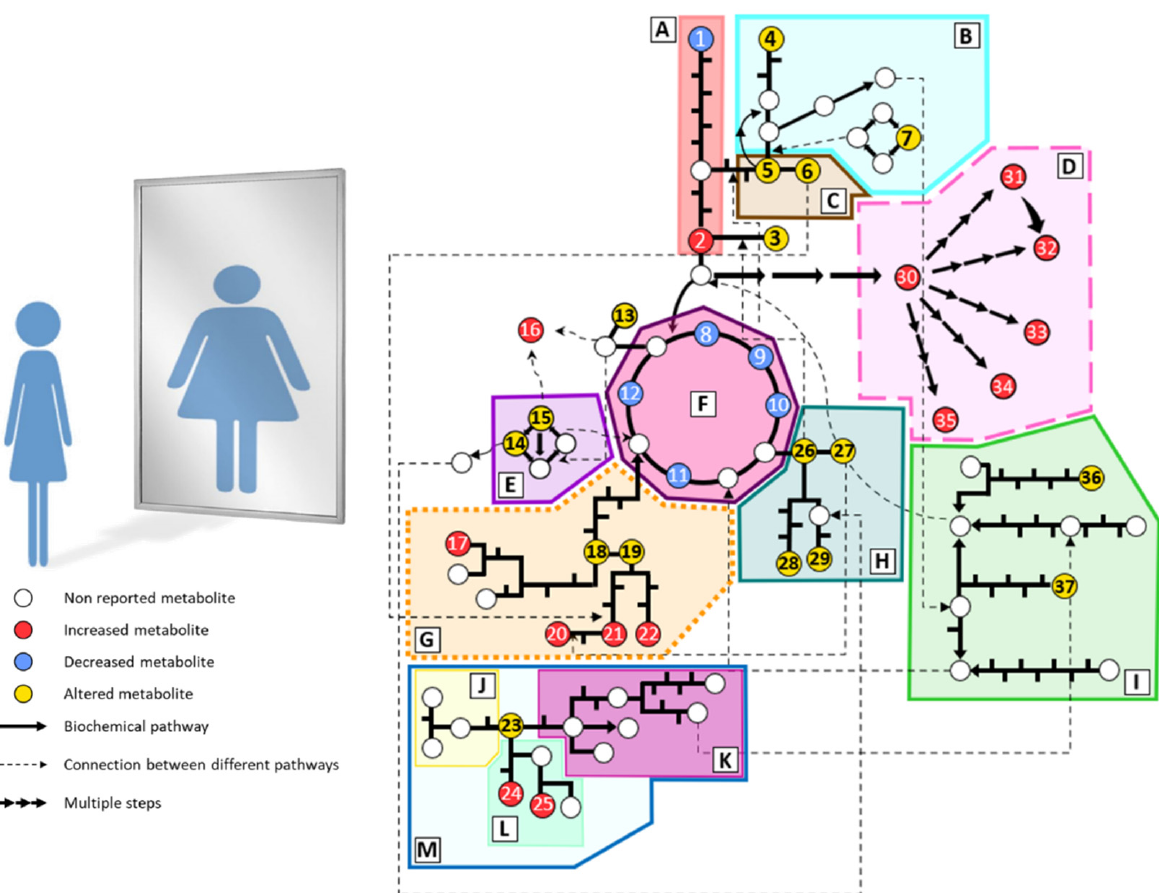
Figure 2. Summary of the main metabolomic alterations found in plasma or serum samples from AN patients in the included studies. Altered pathways: ( A ) glycolysis and gluconeogenesis, ( B ) methionine and cysteine metabolism, ( C ) serine and glycine metabolism, ( D ) lipid metabolism, ( E ) urea cycle, ( F ) tricarboxylate cycle, ( G ) phenylalanine and tyrosine metabolism, ( H ) glutamate, glutamine, proline and histidine metabolism, ( I ) branched-chain amino acids metabolism, ( J ) serotonin pathway, ( K ) kynurenine pathway, ( L ) indole pathway, ( M ) tryptophan metabolism. Metabolites: (1) glucose, (2) pyruvate, (3) alanine, (4) taurine, (5) serine, (6) glycine, (7) methionine, (8) citrate, (9) cis-aconitate, (10) isocitrate, (11) succinate, (12) malate, (13) asparagine, (14) ornithine, (15) arginine, (16) guanidinosuccinate, (17) p -cresyl sulfate, (18) tyrosine, (19) phenylalanine, (20) phenylacetylglutamine, (21) phenylacetate, (22) hippurate, (23) tryptophan, (24) indole-3-acetate, (25) indoxyl sulfate, (26) glutamate, (27) glutamine, (28) histidine, (29) proline, (30) fatty acids, (31) phosphatidylcholines, (32) lysophosphatidylcholines, (33) sphingomyelins, (34) acylcarnitines, (35) oxylipins, (36) leucine, (37) isoleucine.